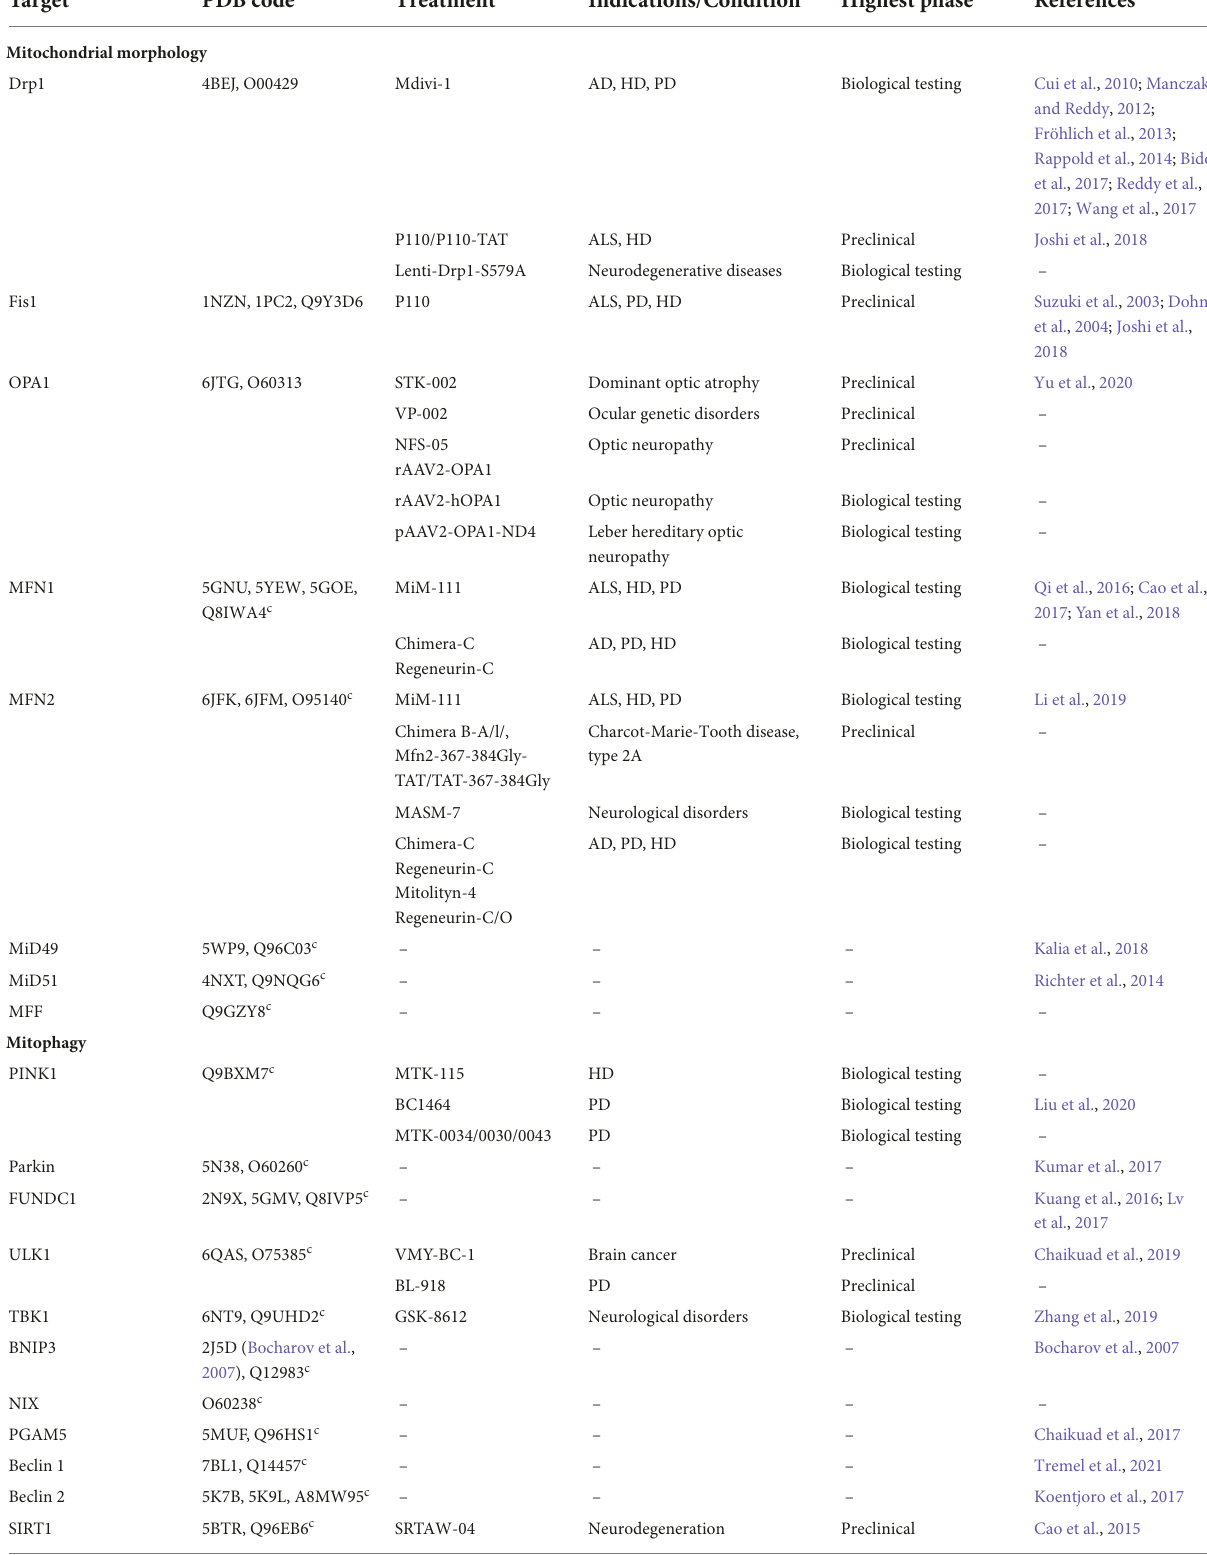
TABLE 2 Mitochondrial quality control (MQC)-associated proteins and therapeutic agents in brain diseases.